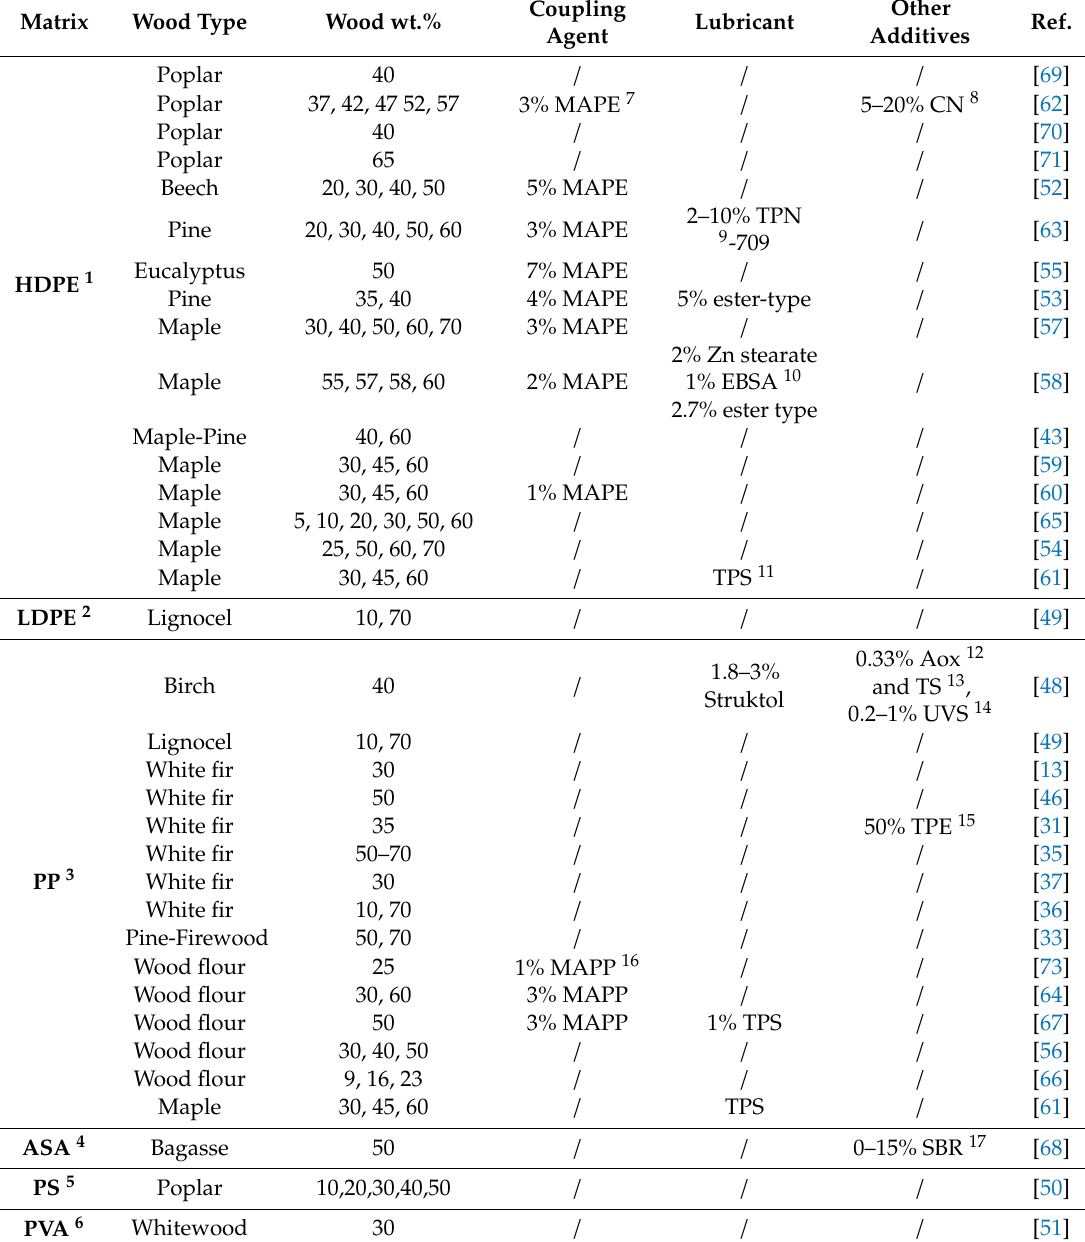
Table 3. Wood polymer composites (WPC) formulations characterized with pressure-driven viscometry in the